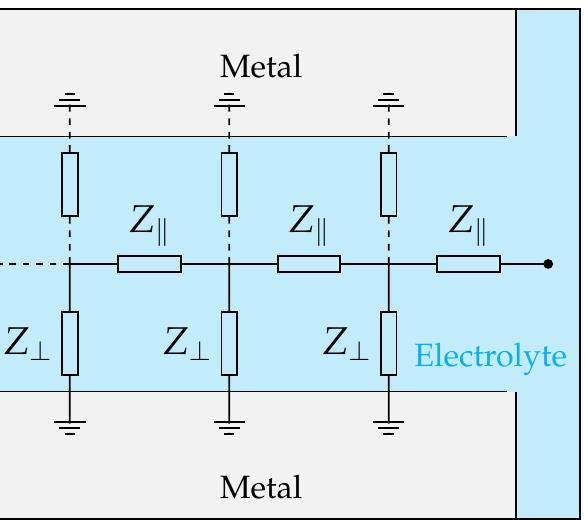
Figure A1. Equivalent scheme of an infinite pore according to Levie’s theory. The direction of the pore deepening is shown from right to left. Here, Z is the impedance of the metal/electrolyte interface, ⊥ and Z is the impedance of the pore cross-section. ∥